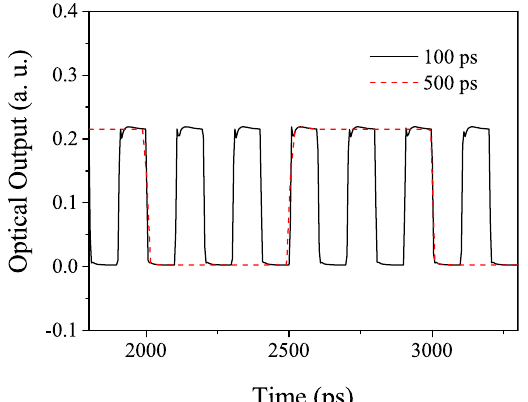
Figure 5. NRZ pulse train modulation output with pulse intervals of 100 ps and 500 ps. The NRZ pulse train consists of alternate ‘0’ and ‘1’ codes with a voltage of 2.0